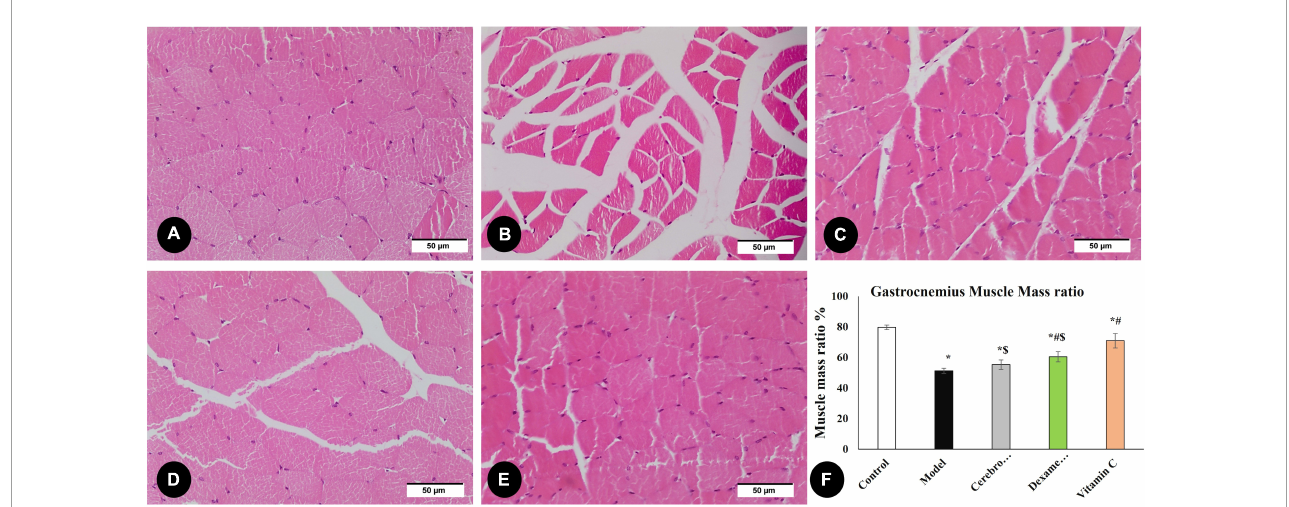
FIGURE5 H&E staining of the gastrocnemius muscle in the control group (A) , the model group (B) , the Cerebrolysin group (C) , dexamethasone group (D) , and vitamin C (E) . (F) Histogram illustrates a comparison of area percentage of gastrocnemius muscle fibers between different groups. *Significance as compared to control, # significance as compared to the model, and $ significance as compared to Vit C group.